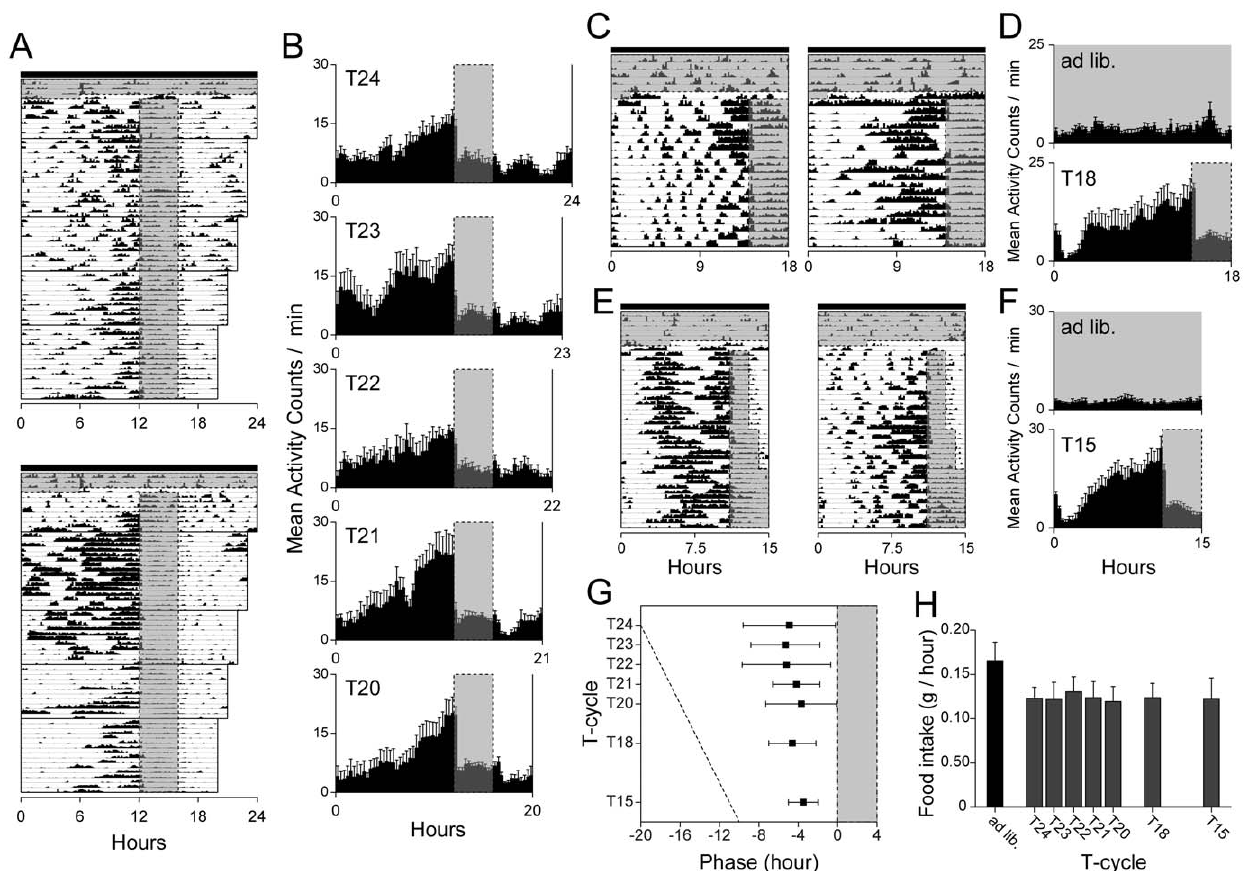
Figure 4. Broader range of pre-feeding activity rhythms in Bmal1 -deficient mice. ( A ) Representative actograms of locomotor activity plotted at a day length corresponding to each feeding schedule in Bmal1 2 / 2 mice. Time is plotted left-to-right in 10-min bins. Feeding time is indicated by gray shaded boxes. ( B ) Mean profiles of locomotor activity are plotted along each RF schedule (n=5). Mean profile was calculated using individual mean 7-day profiles. Representative actograms of locomotor activity plotted at a day length corresponding to 18-h ( C ) and 15-h ( E ) RF schedules in Bmal1 2 / 2 mice. Mean profiles of locomotor activities are plotted along 18-h ( D , n=7) and 15-h ( F , n=7) RF schedules in a 20-min bin. ( G ) Pre-feeding activity phases (circular analysis for individuals) to T-cycle schedules. Error bar indicates mean inter-day deviation of pre-feeding activity phases. ( H ) Food intake per hour during ad libitum and RF conditions.